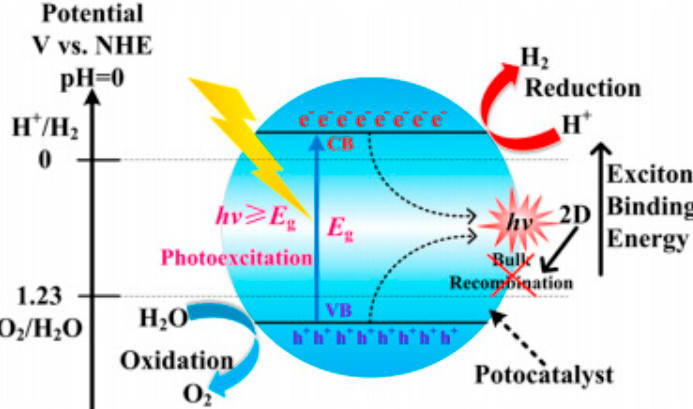
Figure 1. Schematic illustration of basic processes in photocatalytic water splitting. (Reprinted with permission from ACS Catal. 2018, 8, 3, 2253–2276, Publication Date: 30 January 2018. Copyright (2018) American Chemical Society[23].)